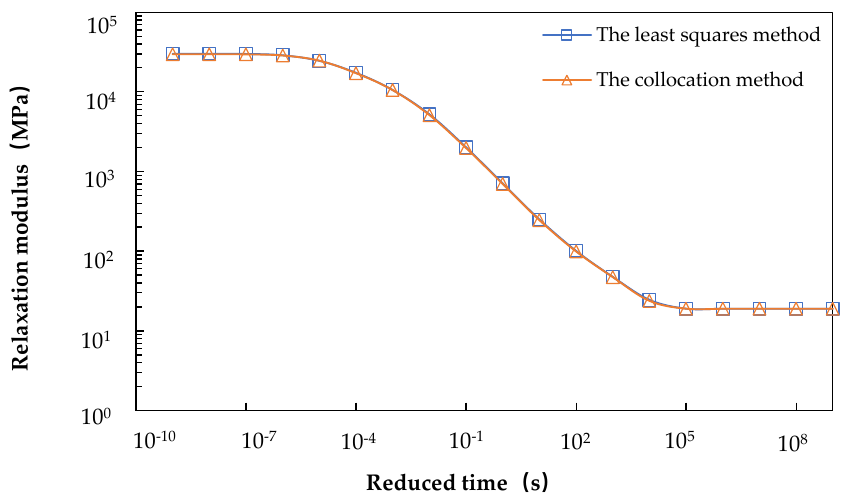
Figure 4. Relaxation modulus master curve converted from creep compliance through collocation method and least squares method in log-log scale.